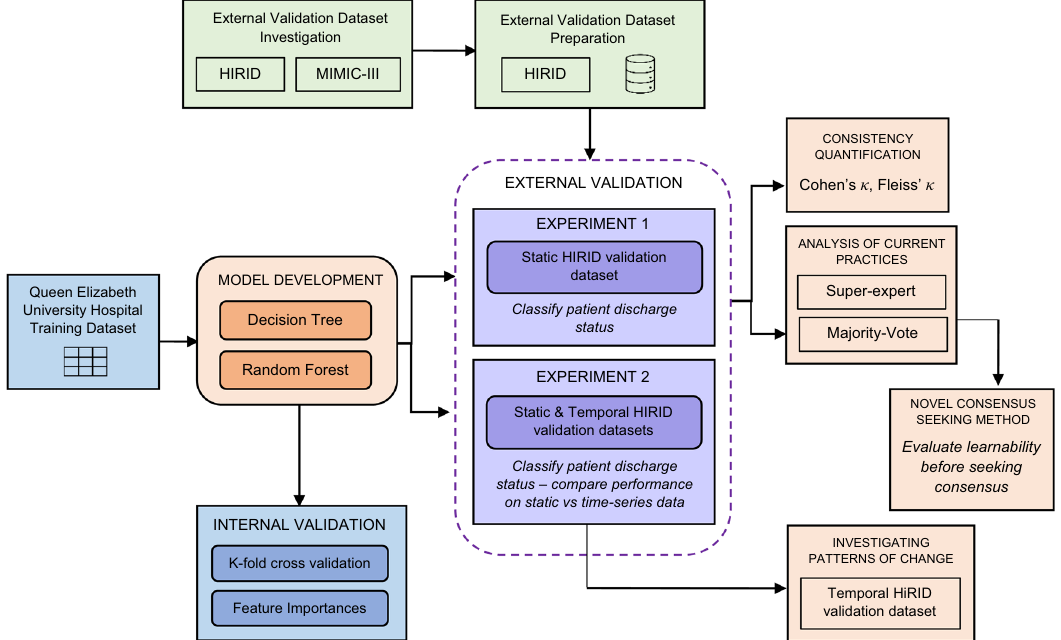
Fig. 2 Overview of the experimental approach, outlining the data fl ow and key analytical steps. The left component (with three boxes) illustrates the model derivation including dataset, models and internal validation methods. The top component with two green boxes denotes the external validation dataset selection and preparation. The middle component (circled by a dashed line) shows the external validation experiments. The right component (with four pink boxes) describes the external validation experiment details including inconsistent measurements, consensus seeking methods and decision making considering changing